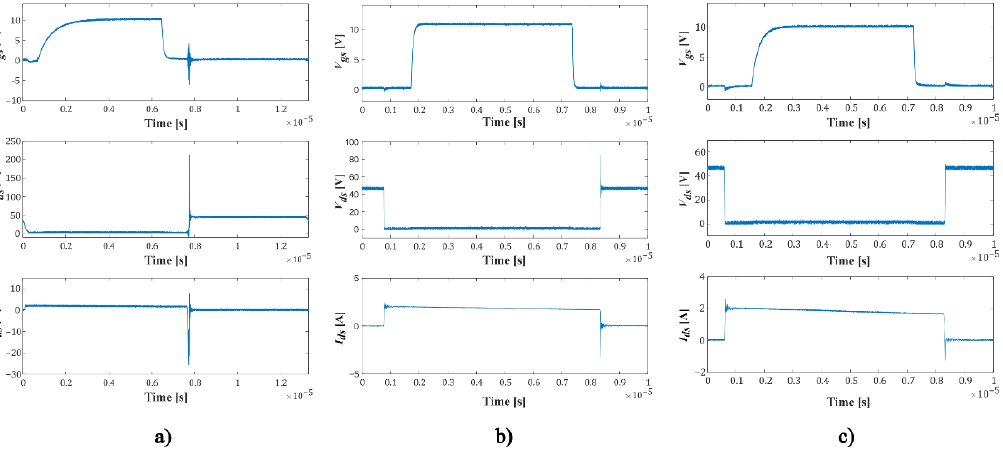
Figure 6. Results of experimental measurements for 3 different cases: ( a ) false turn-on; ( b ) switching with gate resistor 𝑅 𝑔 = 15 Ω ; ( c ) switching with gate resistor 𝑅 𝑔 = 82 Ω .